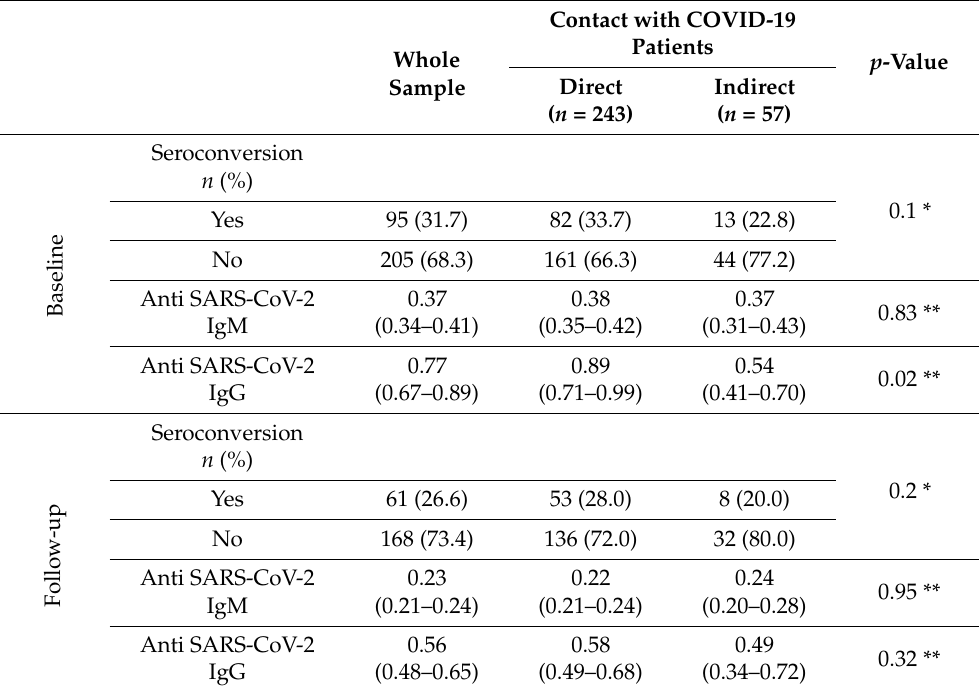
Table 2. Serologic findings of the study